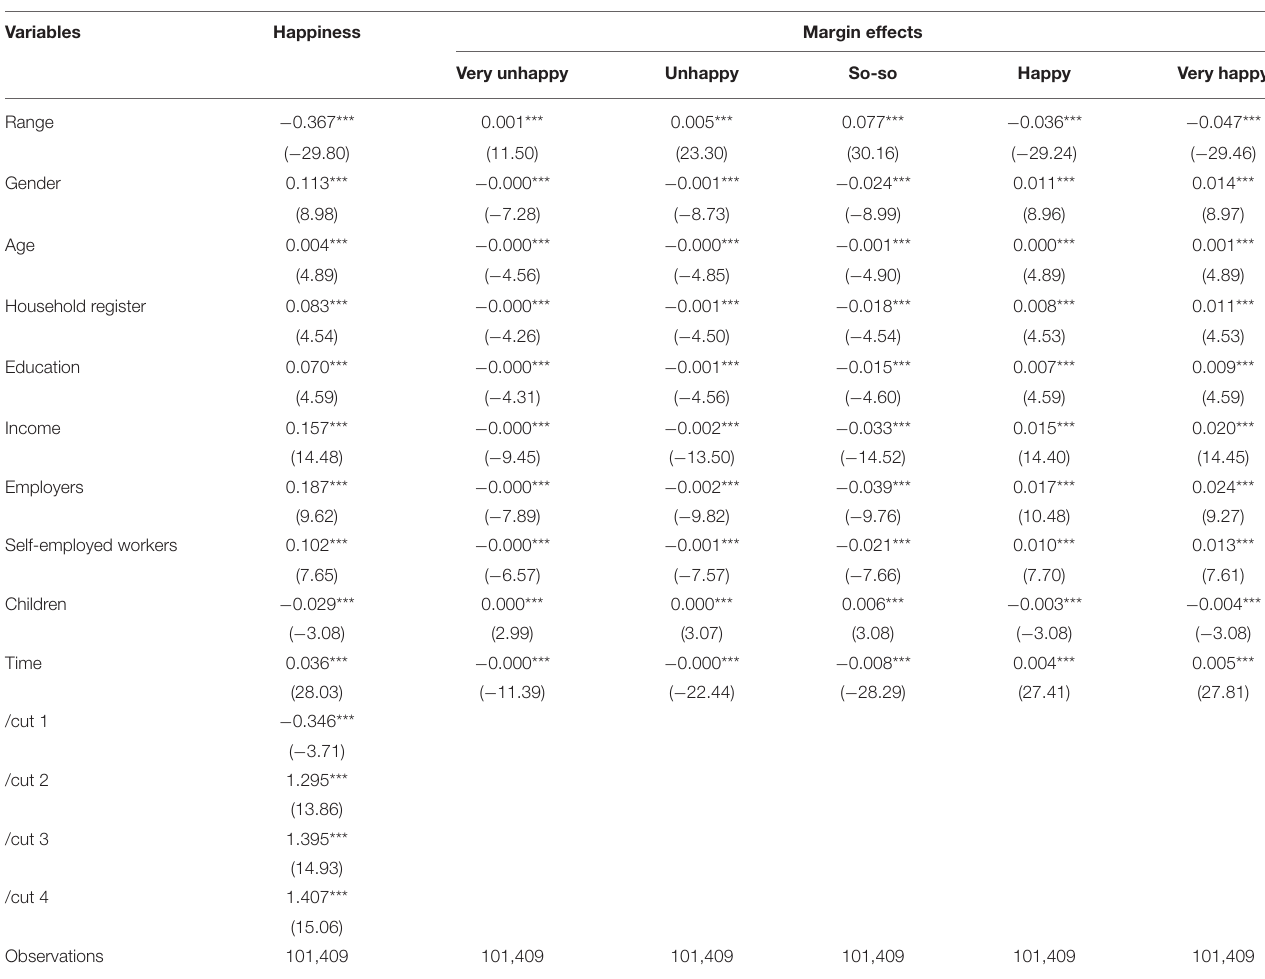
TABLE 2 | The effect of migration distance on